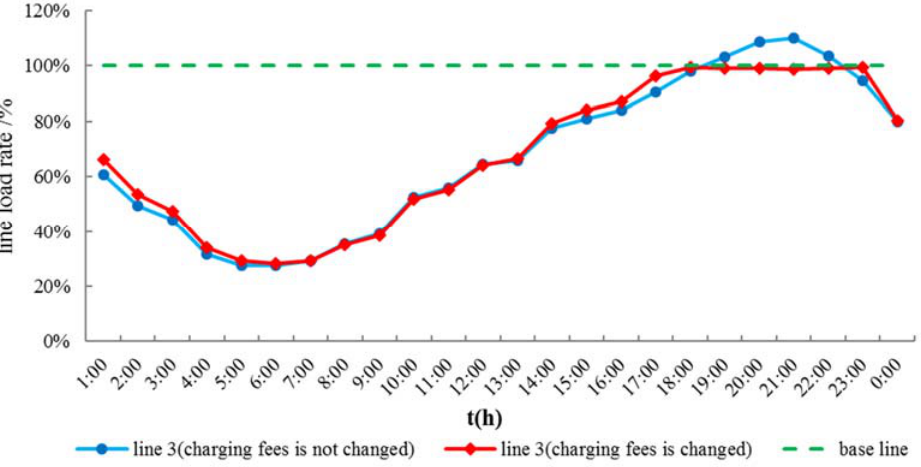
Figure A2. Line load rate of line 3 before and after adjustment for charging fees.